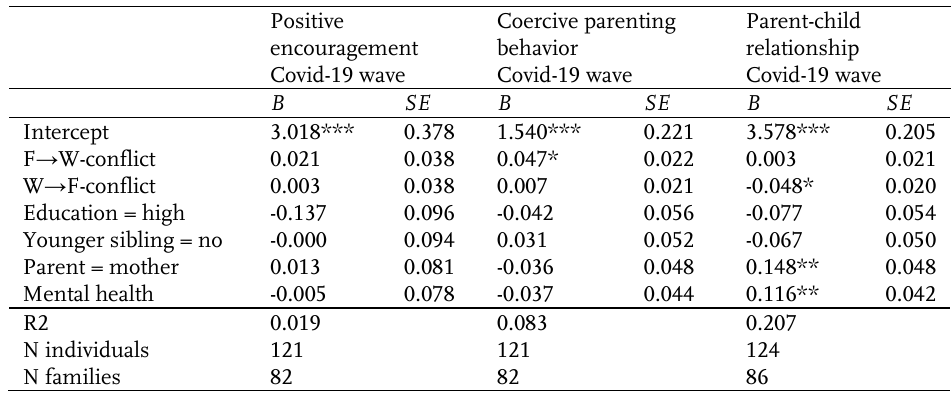
Table A.3c: Multilevel regression models on perceived parenting among mothers and fathers during the Covid-19 wave, while controlling for financial worries. Positive Coercive parenting encouragement behavior